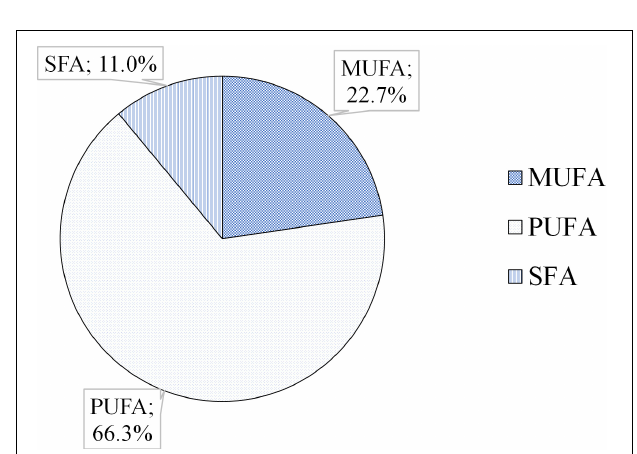
FIGURE 5 | Average content of polyunsaturated fatty acids (PUFA), monounsaturated fatty acids (MUFAs), and saturated fatty acids (SFA) in seeds of five quinoa varieties harvested in 2 years (2017 and